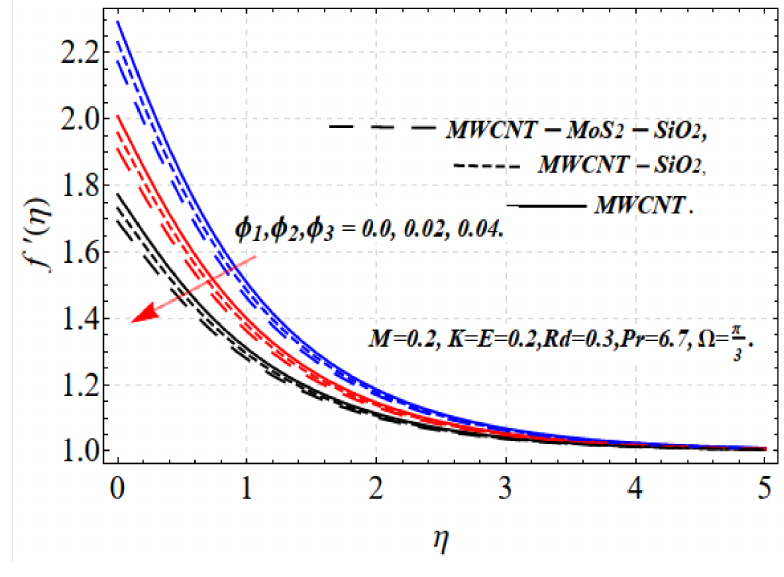
Figure 2. f (cid:48) ( η ) vs. φ 1 , φ 2 , φ 3 .